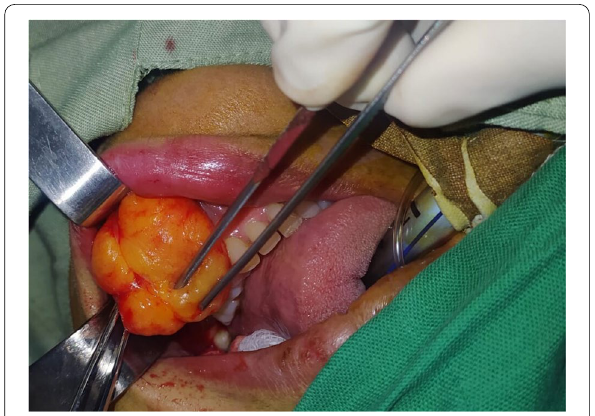
Fig. 2 Per-operative image showing the extirpation of a lipoma of the inferior oral